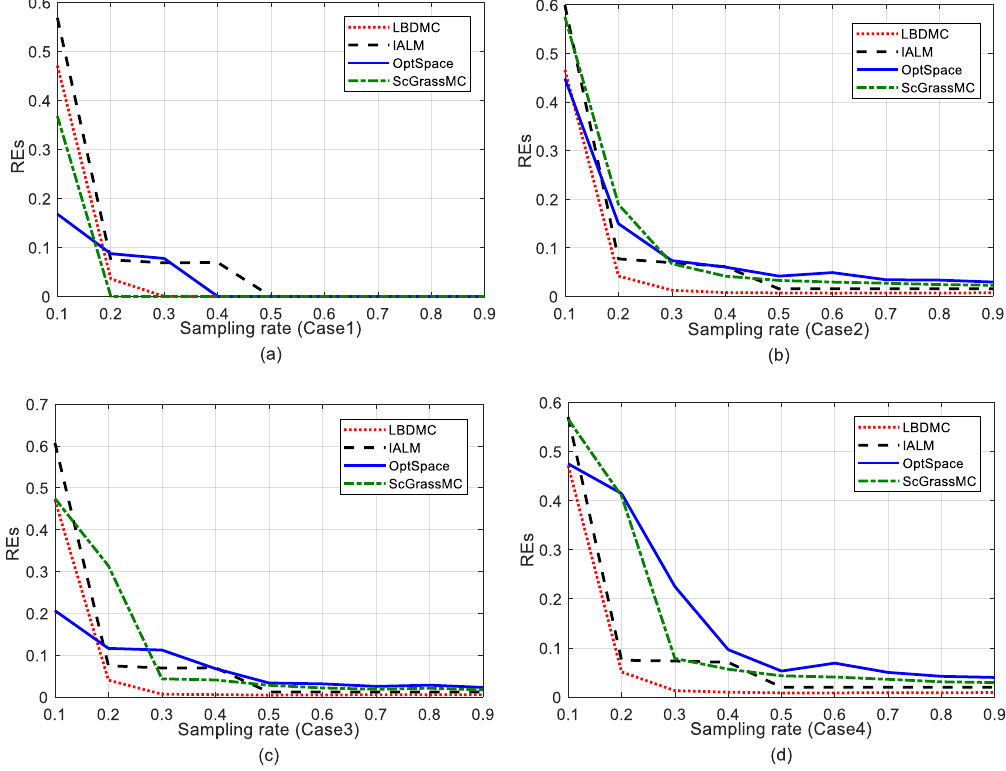
Figure 3. Comparison of EDM recovery errors under different noise conditions. The sampling rate varies successively from 10% to 90%: ( a ) EDM recovery errors under Case 1; ( b ) EDM recovery errors under Case 2; ( c ) EDM recovery errors under Case 3; ( d ) EDM recovery errors under Case 4.